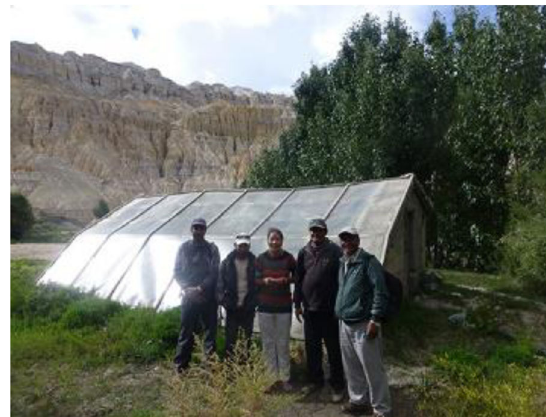
Fig. 13 Horses are used for thrashing crops traditionally